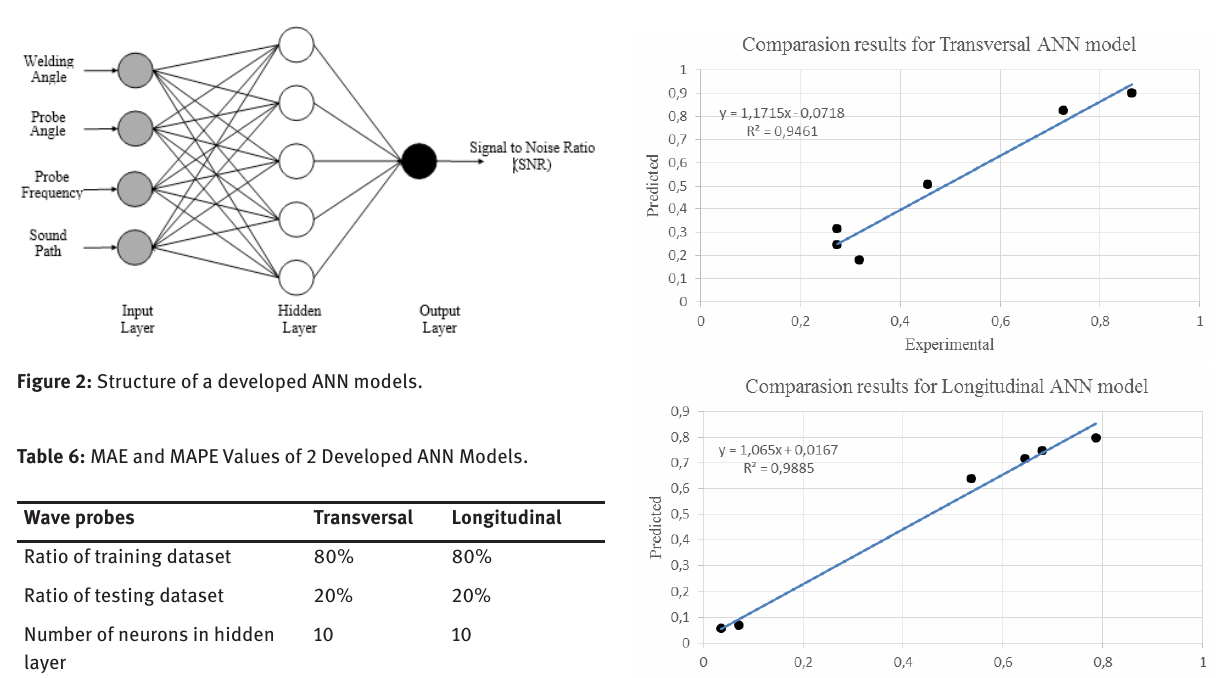
Table 6: MAE and MAPE Values of 2 Developed ANN Models. Wave probes Transversal Longitudinal